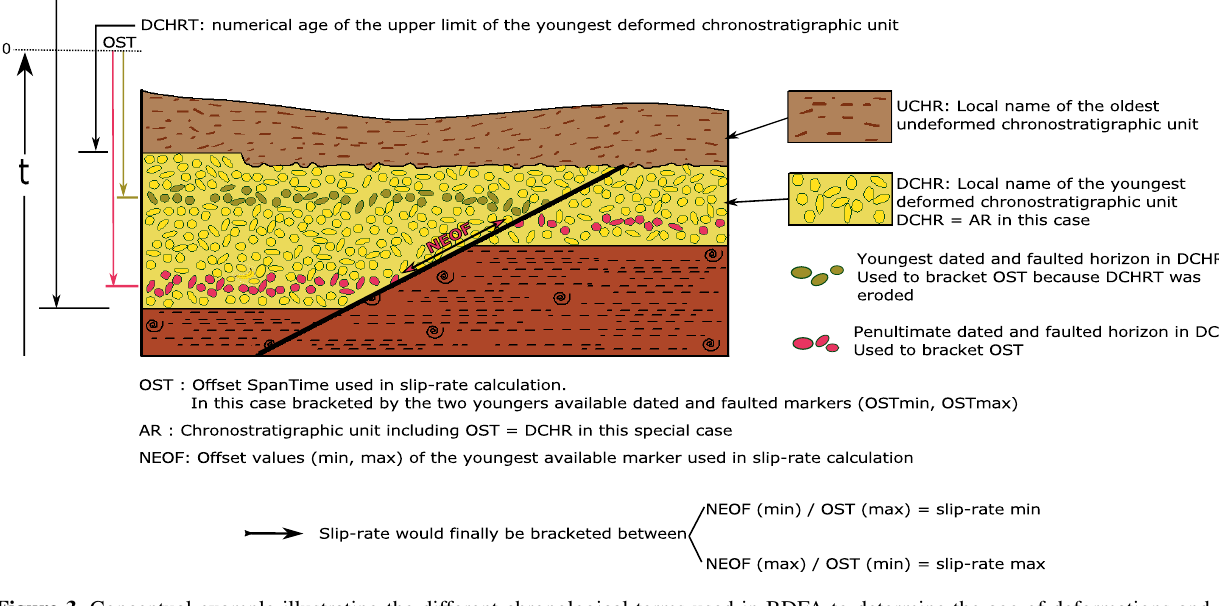
Figure 3. Conceptual example illustrating the different chronological terms used in BDFA to determine the age of deformations and slip